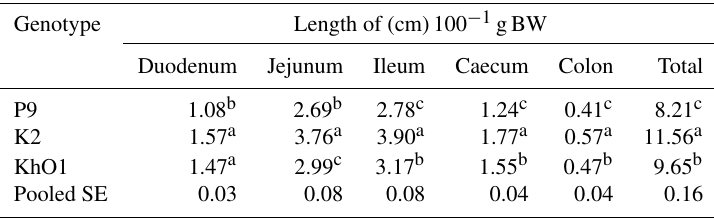
Table 3. Relative length of intestine segments in spent ducks.